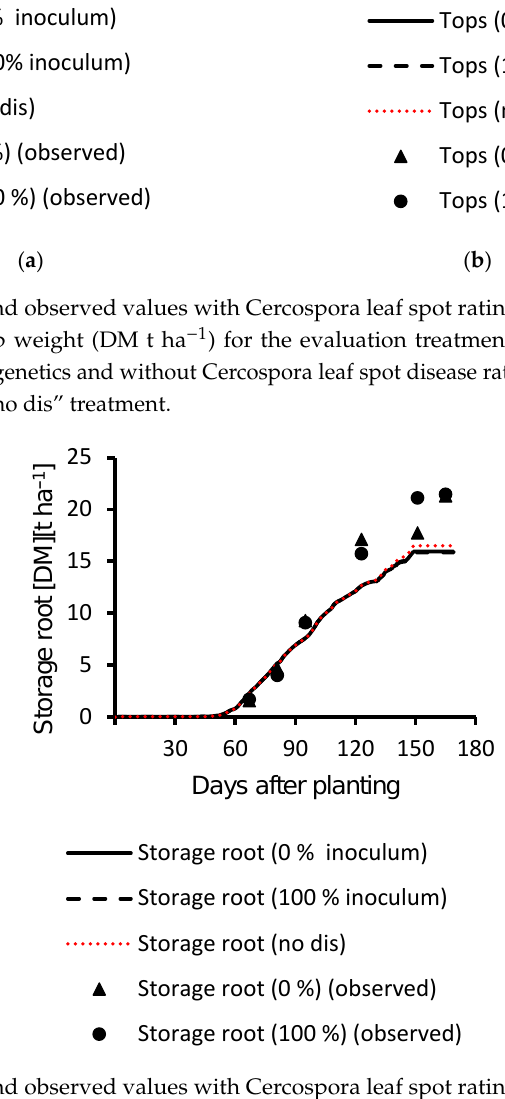
Figure 12. Simulated and observed values with Cercospora leaf spot ratings included in simulation results: storage root weight (DM t ha −1 ) for the evaluation treatment with sugar beet growth simulated with current genetics and without Cercospora leaf spot disease ratings being included in the simulation process as “no dis” treatment.